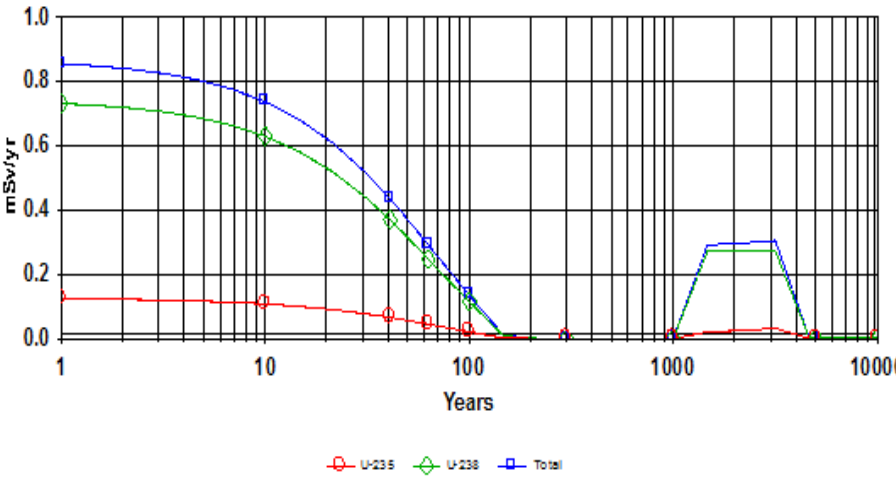
Fig.3: Annual dose over the time of area (A) for resident farmer scenario.